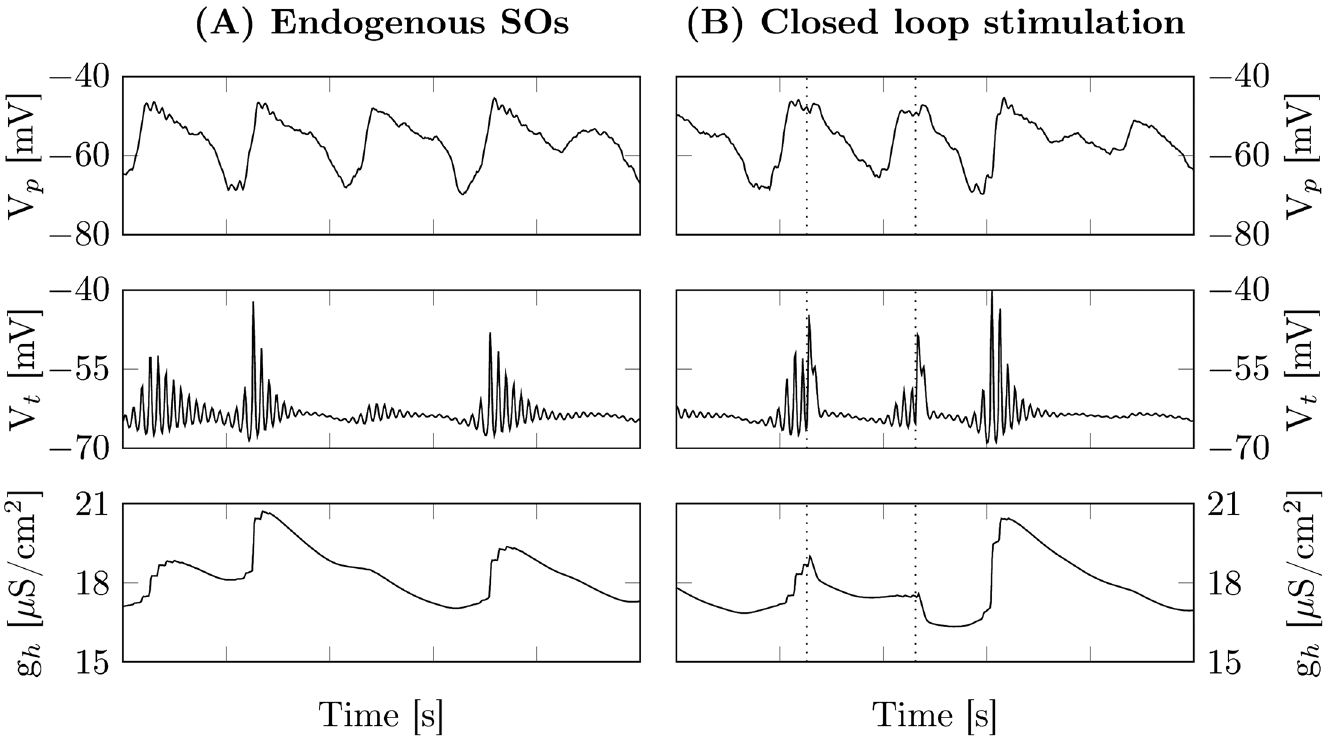
Fig 8. Stimulation disturbs refractoriness. The upper two panels depict the membrane voltages of the pyramidal and thalamic relay populations, respectively. In the third panel the conductivity of the I h current is shown. (A) Example time series of an unperturbed train of SOs during sleep stage N3. The first two SOs lead to an activation of I h , that slowly declines back to baseline levels. As I h activation is still well above baseline, the third SO is unable to trigger a spindle response. During the fourth SO I h activation is sufficiently low so that a spindle occurs. (B) Shown is an example of closed loop stimulation during sleep stage N3, with the dashed lines indicating stimulus onset. In contrast to the endogenous case, the depolarization of the thalamic relay population induced by the stimulation leads to a rapid decrease in I h activation, so that the following SO triggers a spindle. Parameters as in Table 2.